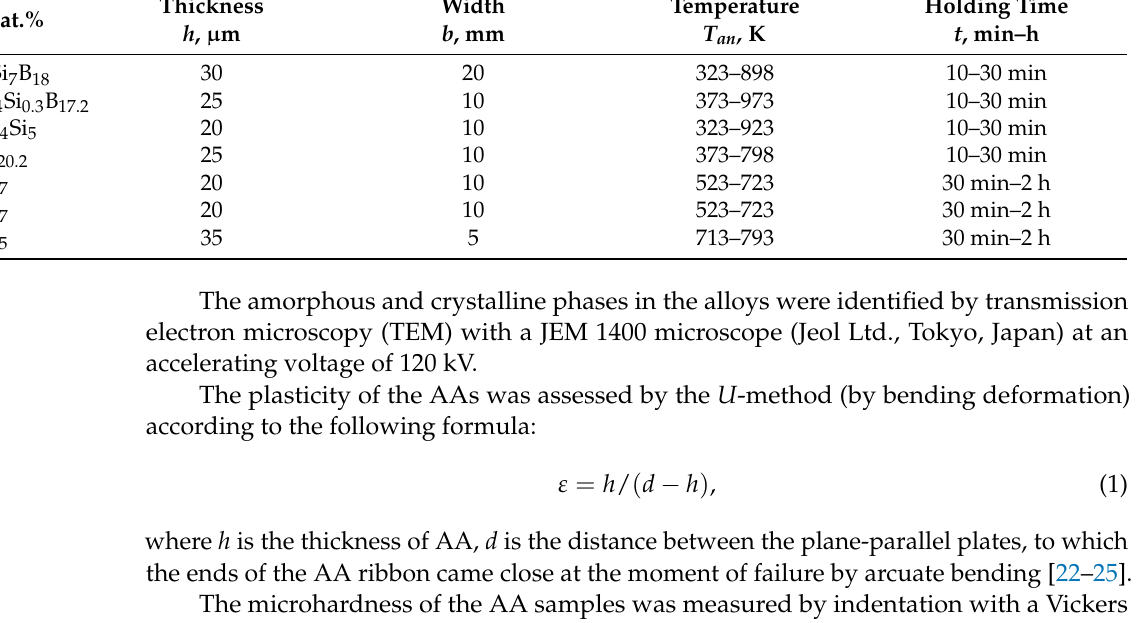
Table 1. Geometrical parameters of AA ribbons and temperature–time ranges of their heat treatment. Composition,